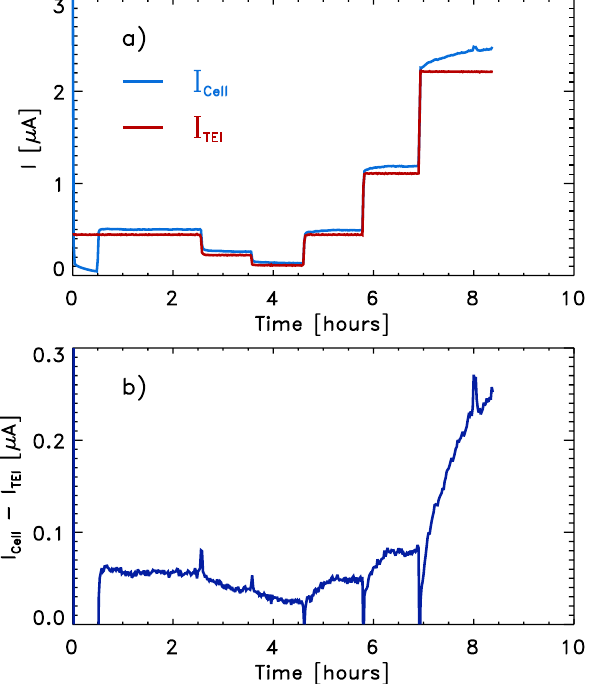
Fig. 4. Excess cell current as function of measured cell current and solution